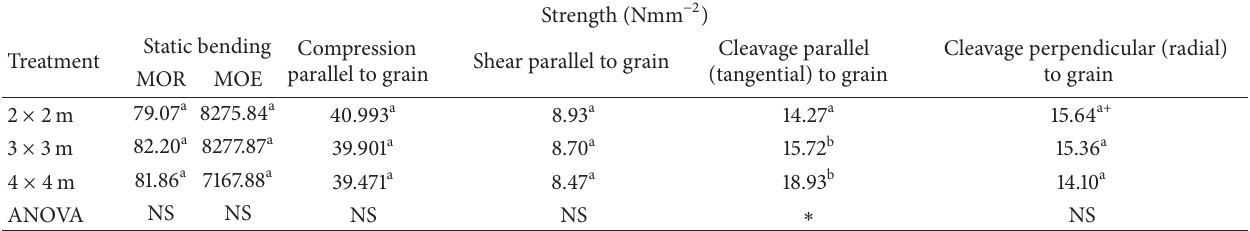
Table 5: Effect of spacing on other wood properties of T. grandis at